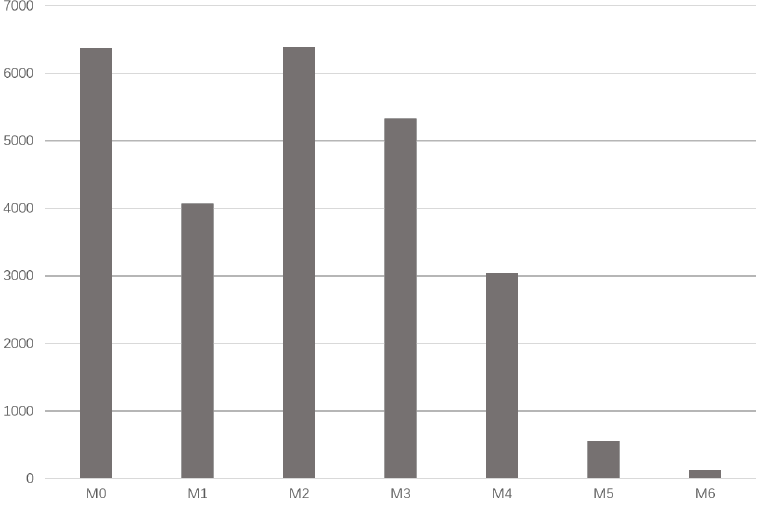
Figure 1. Distribution of M0–M6 dwarfs with signal-to-noise ratio > 5 of Sloan Digital Sky Survey (SDSS)